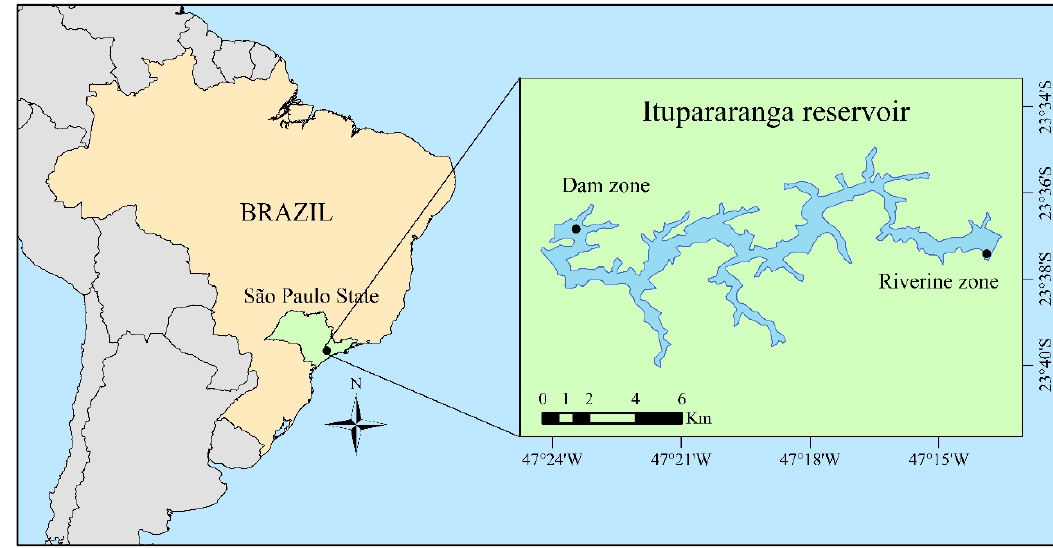
Figure 1. Sampling sites in the Itupararanga reservoir, São Paulo State, Brazil. Itupararanga riverine zone (23°37 ′ 24.8 ″ S, 47°13 ′ 53.4 ″ W); Itupararanga dam zone (23°36 ′ 50.7 ″ S, 47°23 ′ 27.3 ″ W).